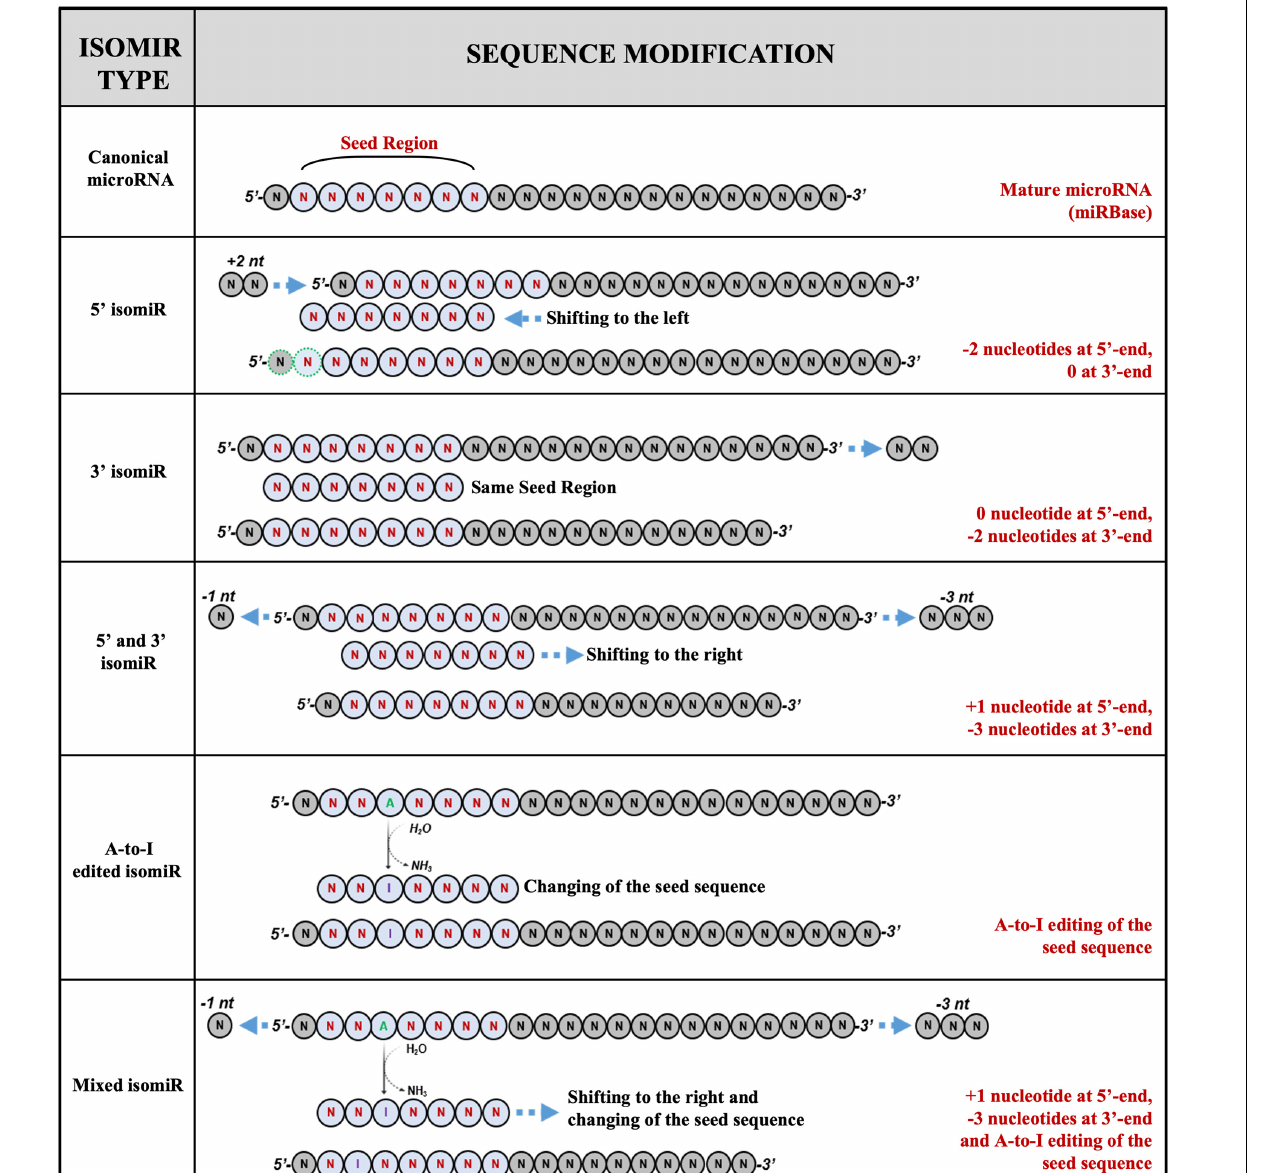
transferases (Wyman et al., 2011). These variants are considered non-templated because they contain nucleotides not existing in the parental gene sequence (Neilsen et al.,